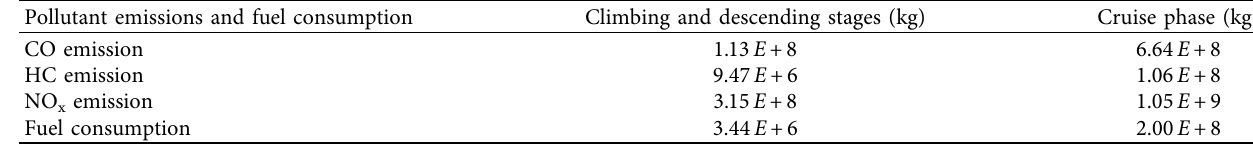
Table 7: Point-to-point network pollutant emissions and fuel consumption.